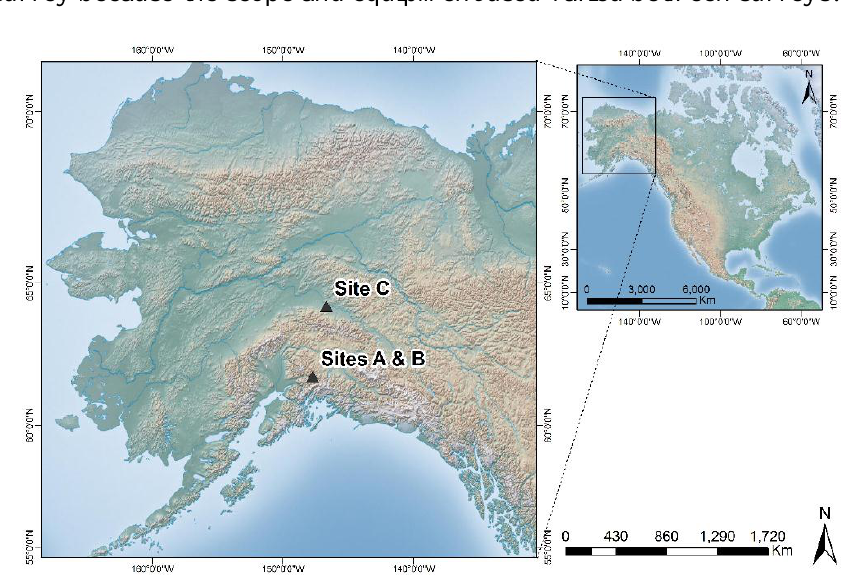
Figure 2. Topographic relief map showing the location of Study Sites A , B and C in Alaska, U.S.A. (Shaded relief map courtesy of the Earth Systems Research Institute,